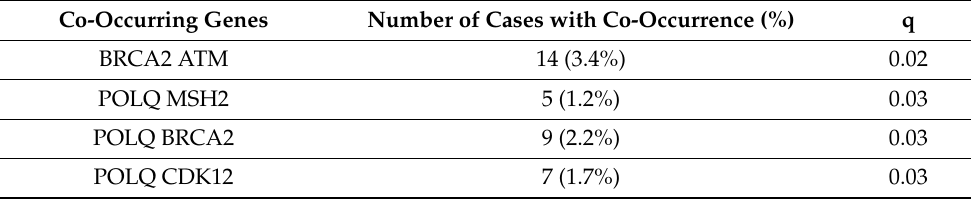
Table 5. Statistically significant co-occurrences between mutations in MMR associated genes, proof- reading polymerases and DNA damage response genes in the whole TCGA bladder carcinoma cohort. Correction for multiple comparisons was performed with the Benjamini-Hochberg false discovery rate